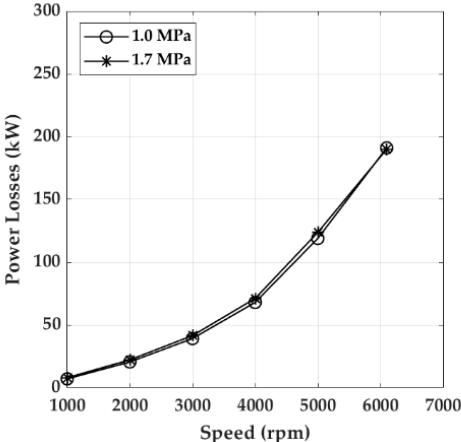
Figure 24. Flooded Ball & Socket Pivot bearing pad power losses.